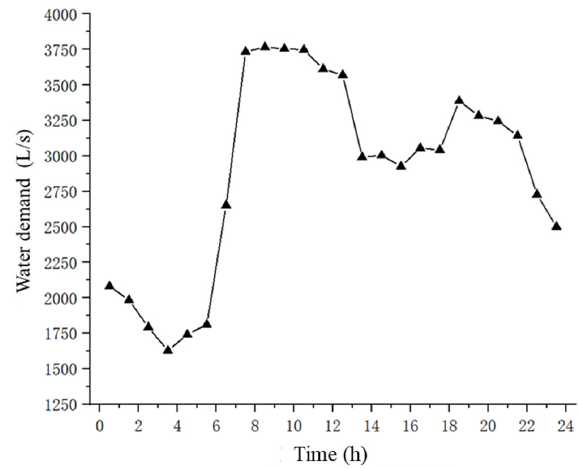
Table 3. Water proportion statistics of each age period in the three scenarios.